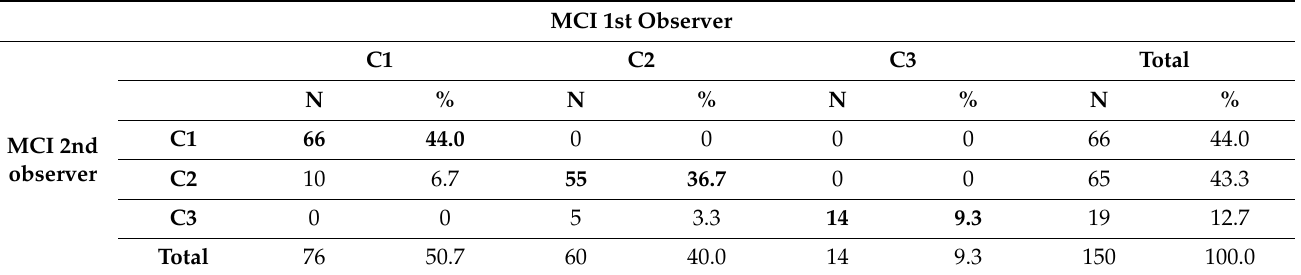
Table 3. Interobserver reliability for MCI index.